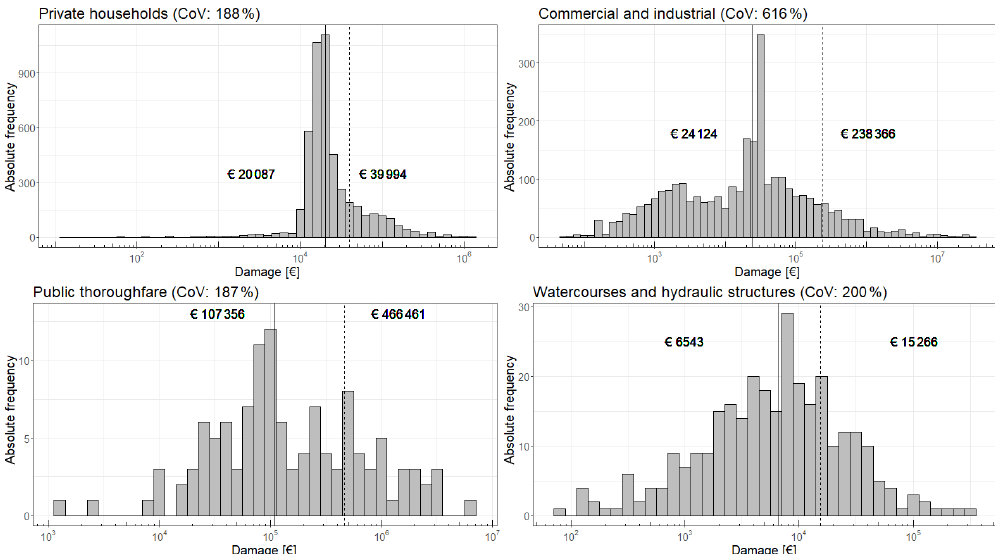
Figure 3. Histograms of total damage values per sector for all records of the HOWAS 21 database. Data are plotted on the logarithmic scale. Solid and dashed lines indicate the median and the mean values, respectively.